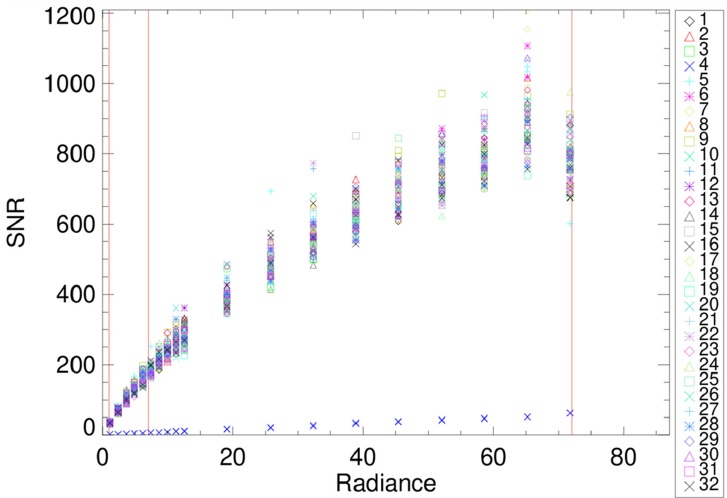
Figure 11. The signal-to-noise ratio (SNR) of band I3 for all detectors (colored symbols) as a function of SIS100 radiance (W/m 2 / µ m/sr). The three vertical red lines are for Lmin (left), Ltyp (middle), and Lmax (right). The decrease in SNR at the Lmax line is due to partial saturation of the signal. This behavior is used help identify valid response data for characterization purposes.